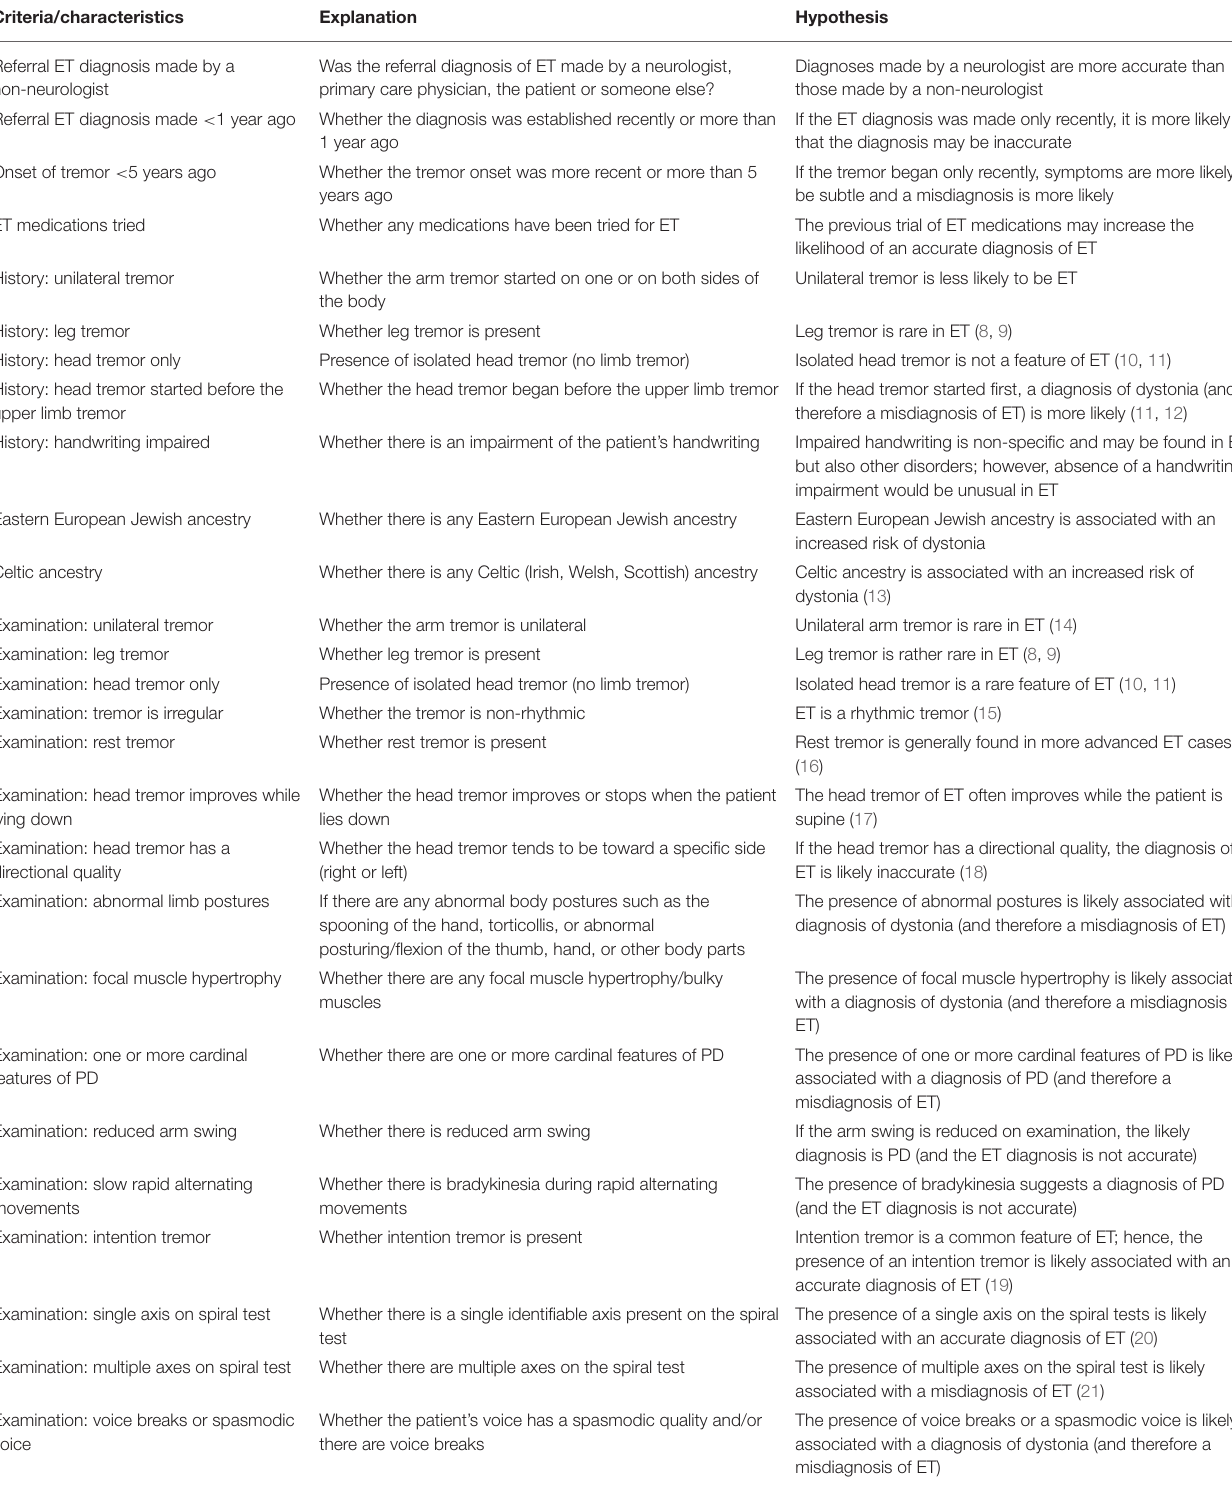
TABLE 1 | Explanation and hypothesis for the historical and clinical characteristics of the included patients.